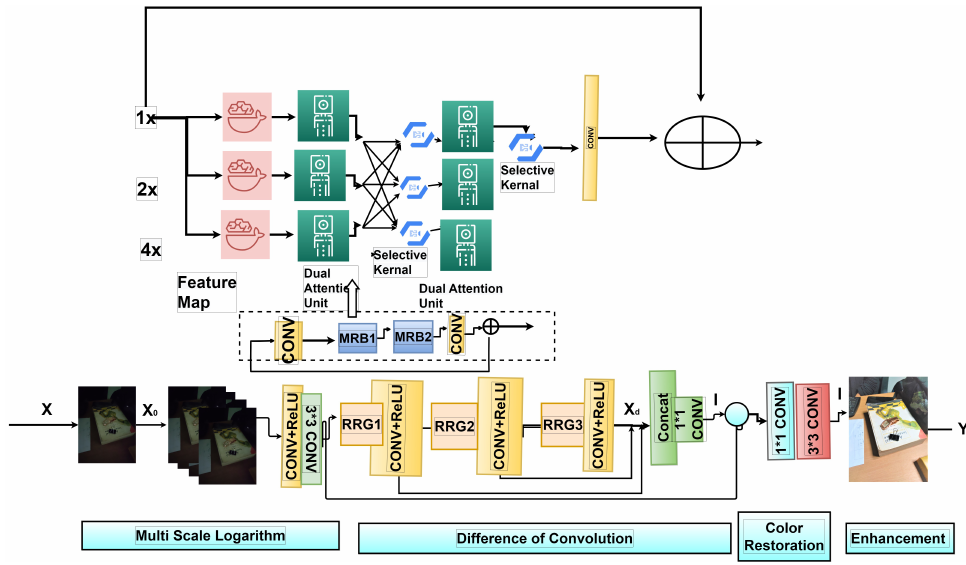
Figure 3. MSR-MIRNeT Model